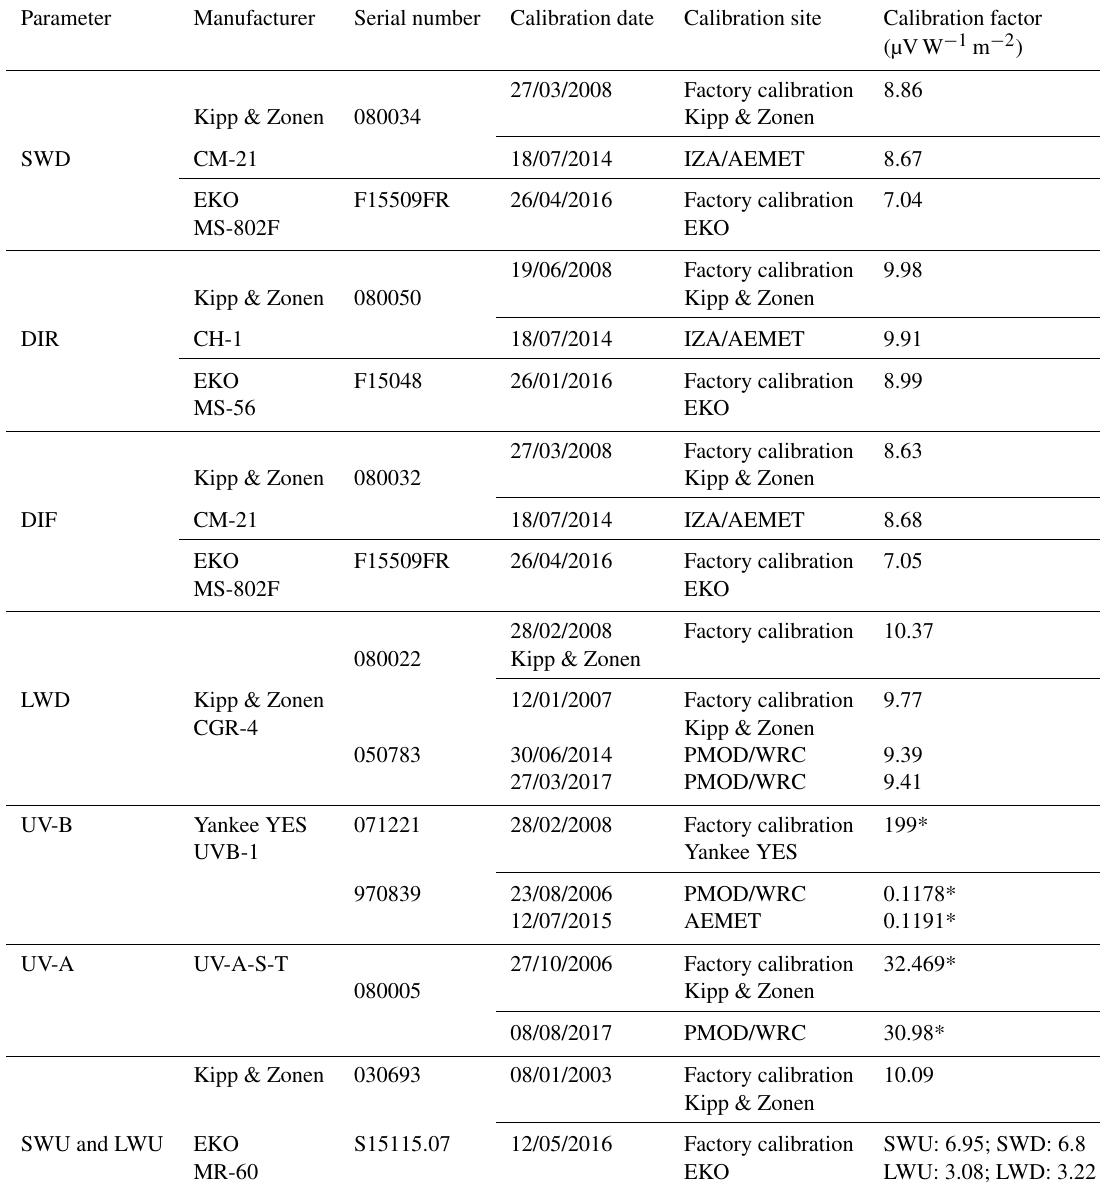
Table 3. Summary of calibrations of the different radiation instruments performed at IZA between 2009 and 2017. PMOD is the Physikalisch- Meteorologisches Observatorium Davos, and WRC is the World Radiation